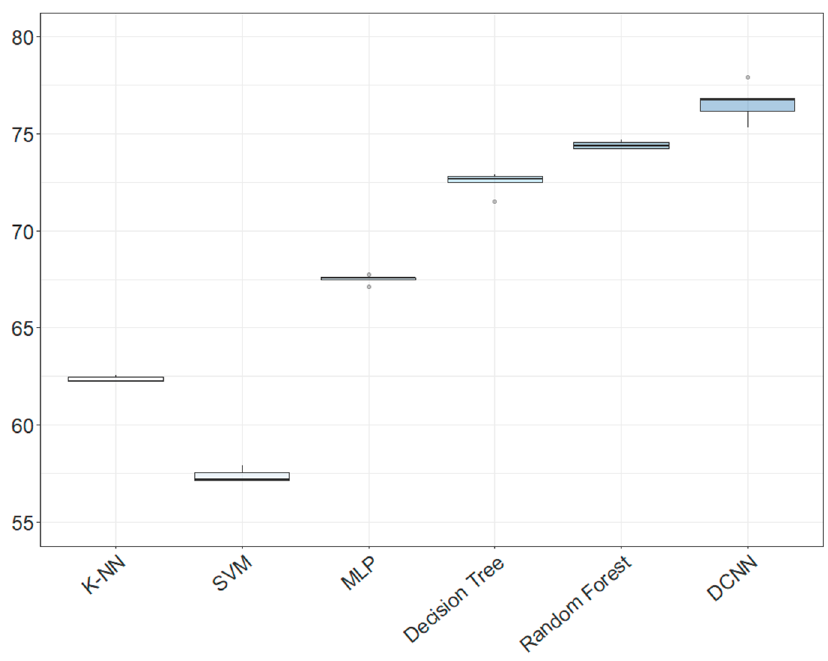
Figure 4. The accuracy of 5-fold cross validation. Table 6. Comparison of the performance by preprocessing and feature extraction methods.